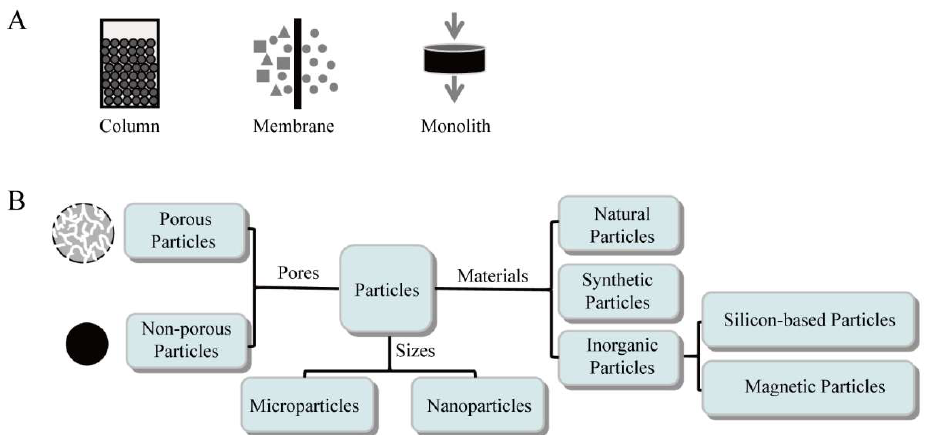
Figure 1. Chromatographic matrix for use in antibody affinity purification. ( A ) Formats of the stationary phase; ( B ) Classification of particles based on different criteria.